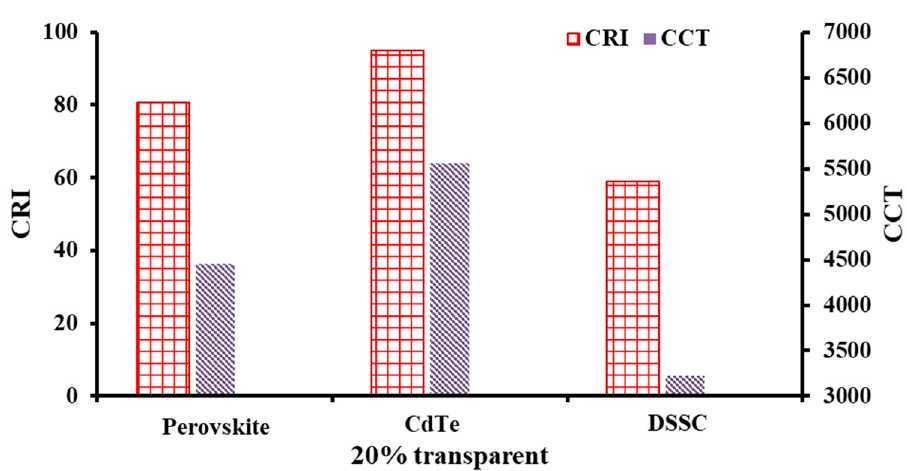
Figure 6. CCT and CRI analysis to evaluate colour comfort using three different type (Perovskite, CdTe, and DSSC) 20% transparent BIPV window.